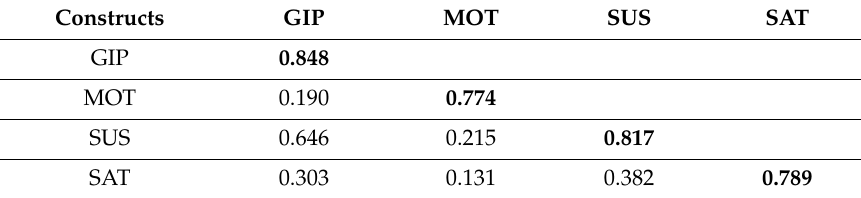
Table 3. Constructs discriminant validity (Fornell–Larcker criterion).